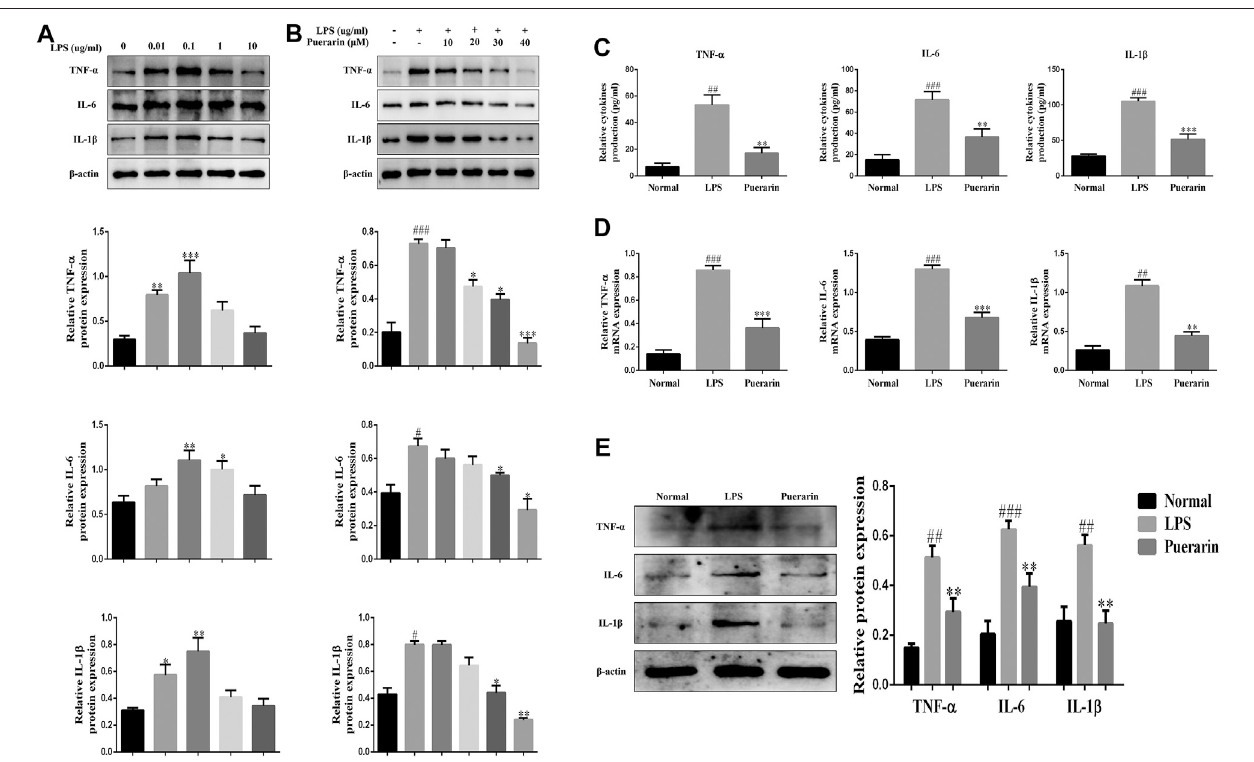
FIGURE 2 | Puerarin reduced the in fl ammatory responses in LPS-induced L-02 cells. (A) and (B) : The protein expression levels of TNF- α , IL-6, and IL-1 β were measuredbyWesternblot(WB)analyses. (C) : Theexpression levels ofTNF- α , IL-6, and IL-1 β were measured by ELISA. (D) : ThemRNA levels ofTNF- α ,IL-6, and IL-1 β were measured using qRT-PCR. (E) : The protein expression levels of TNF- α , IL-6, and IL-1 β were measured using WB analyses. The assays were performed at least threetimes,withsimilarresults.Dataareshownasthemeans ± SD( n (cid:2) 3)ofonerepresentativeexperiment; ###p < 0.001and ##p < 0.01, #p < 0.05versusnormal groups; ***p < 0.001and **p < 0.01 and *p < 0.05 versus the LPS